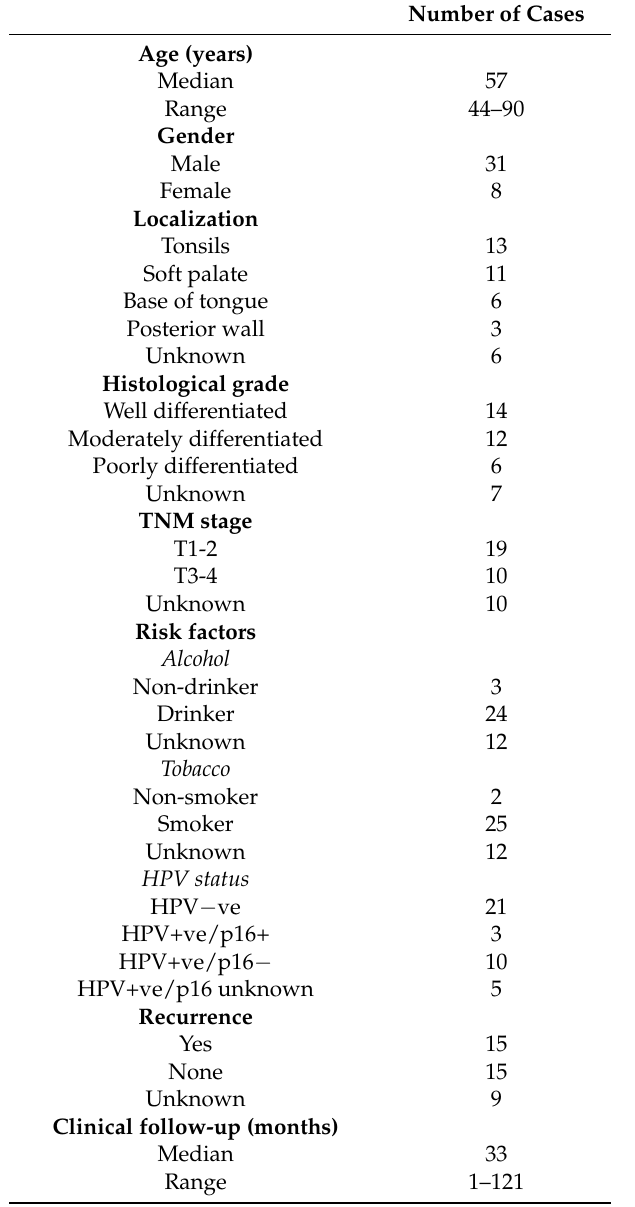
Table 1. Oropharyngeal cancer patients’